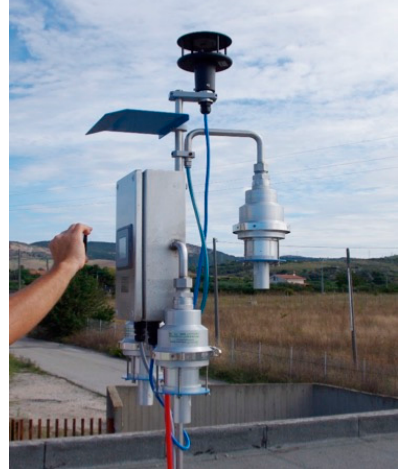
Figure 1. Wind-selective samplers used in this campaign.